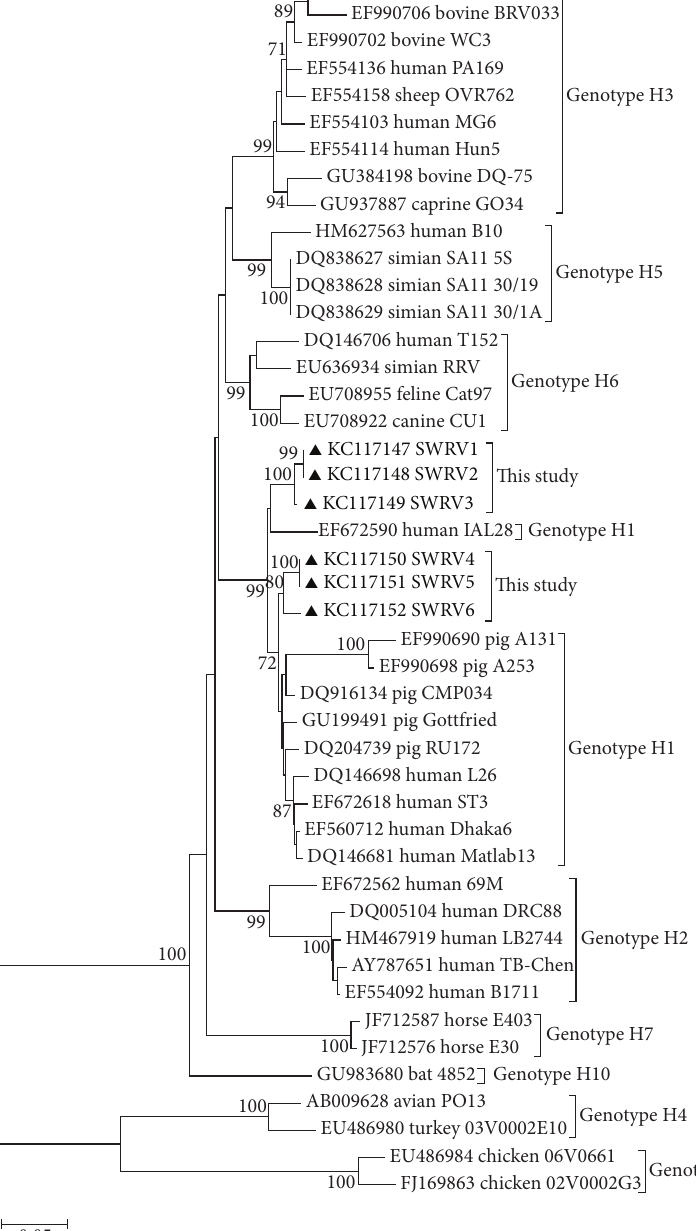
Figure 2: Phylogenetic tree constructed with the neighbor-joining method using maximum composite likelihood as substitution model for the NSP5 complete gene of the group A porcine rotavirus of the strains SWRV1 and SWRV6 with others representing human and animal GARVs. The scale represents the number of substitutions per site. Only bootstrap values > 70% are shown. Pig strains defined in the present study are preceded by black triangles, and they are identified as accession number/host/strain/NSP5 genotype.